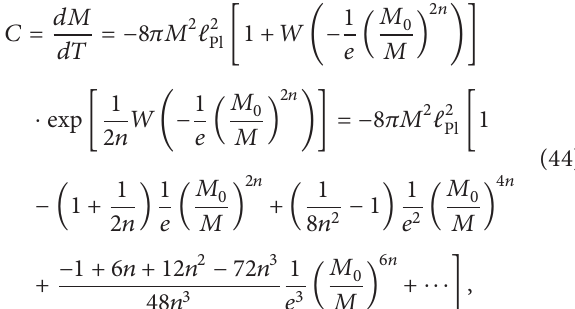
Figure 4: The entropy versus the black hole mass for the case 𝛼 = 1 . Curves are the Hawking result (black) and GUP 𝑛 results for 𝑛 = 2 (red), 𝑛 = 5 (green), and 𝑛 = 10 (blue), respectively. Moreover, the GUP 1 result (purple) is shown for